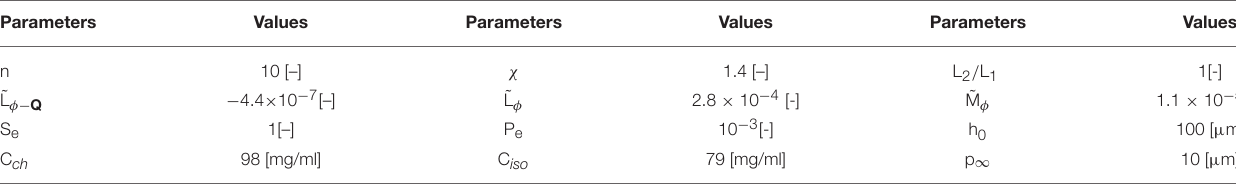
TABLE 1 | The material properties and parameter values used in the present paper. Parameters Values